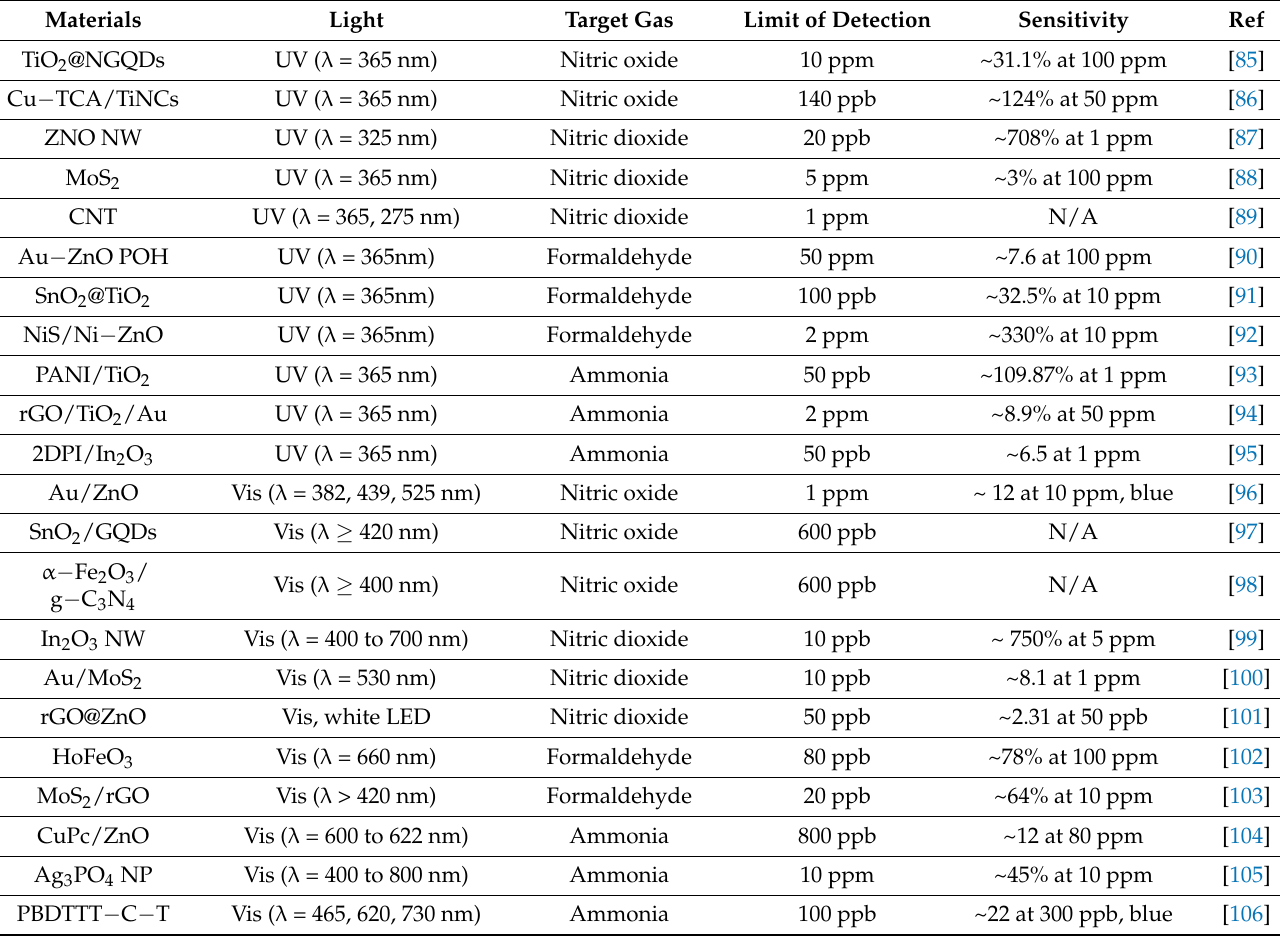
Table 1. Comparison of sensing performance of the photo − activated gas